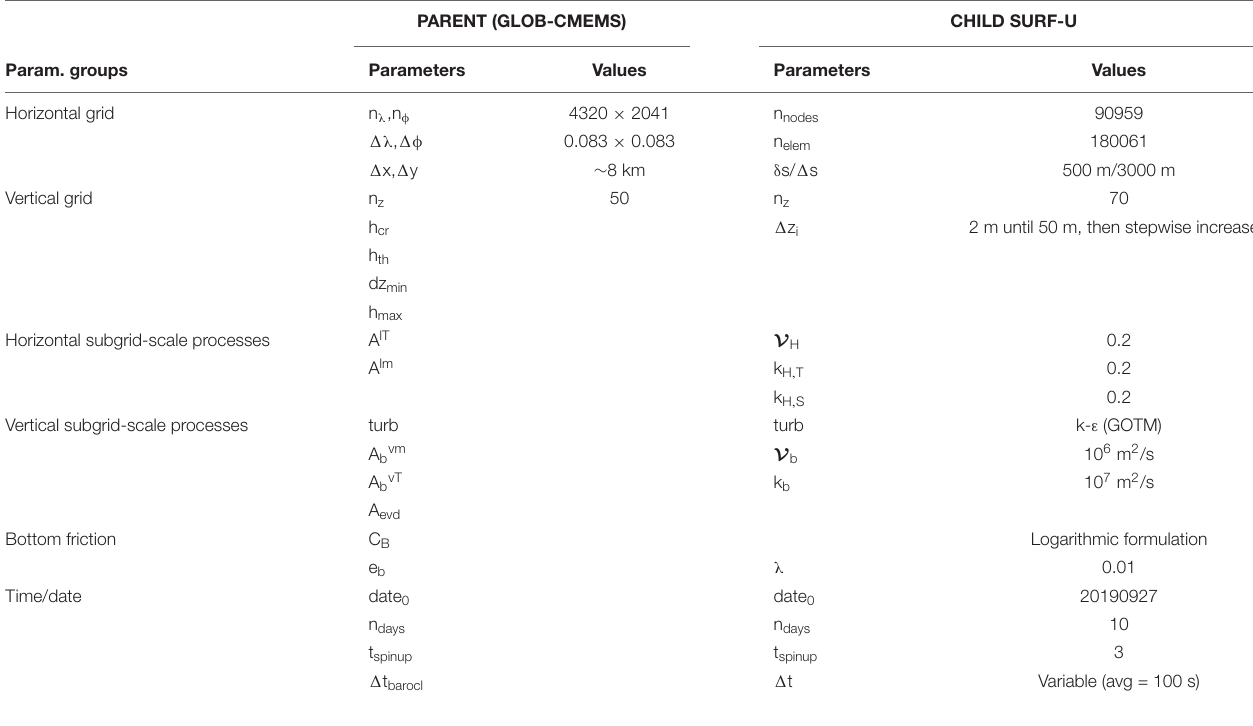
TABLE A3 | Model parameters characterizing the Azores Archipelago study